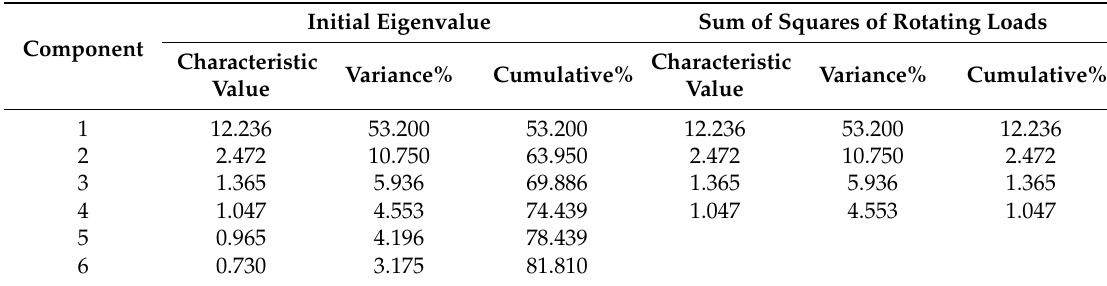
Table 7. Explanation of total